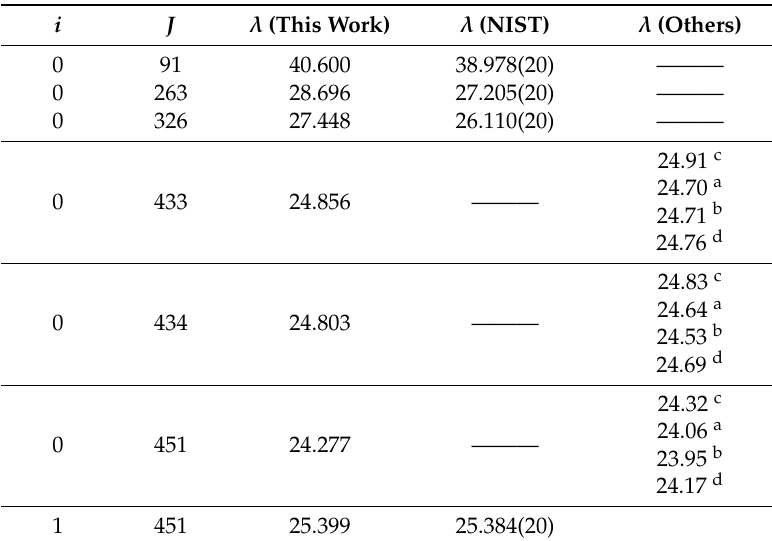
Figure 7. Natural logarithm of the ratio A outF / A out3 of the M1 transition rates calculated in the two largest calculations for W 13 + . The horizontal axis contains the line strengths S outF of the largest calculation in atomic units. Table 13. Comparison of a transition wavelength (in nm) calculated using FAC with NIST [9] and other results for Pm-like W. The indexes of the lower and upper levels, i and j , respectively, correspond to those given in Table